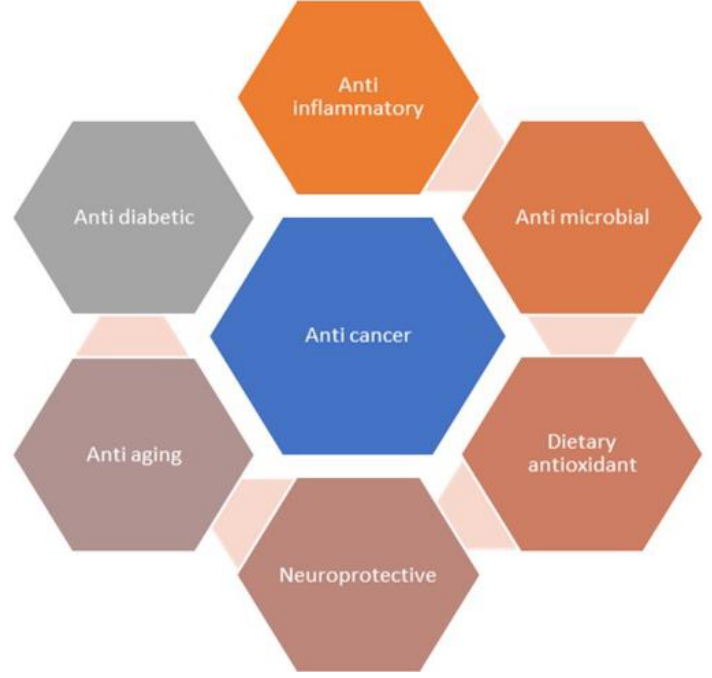
Figure 2. Pharmacological effects of fisetin.